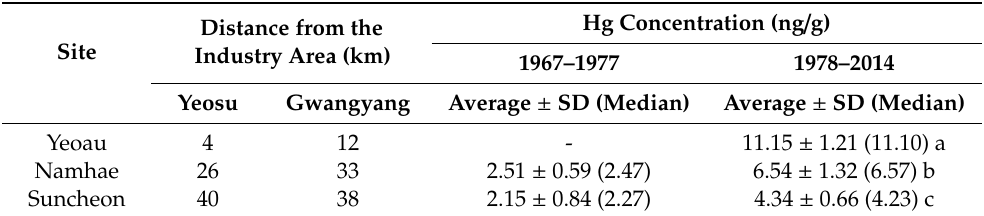
Table 1. Distances from industrial areas to study sites and average Hg concentrations in tree rings at Yeosu, Namhae, and Suncheon sites between 1967 and